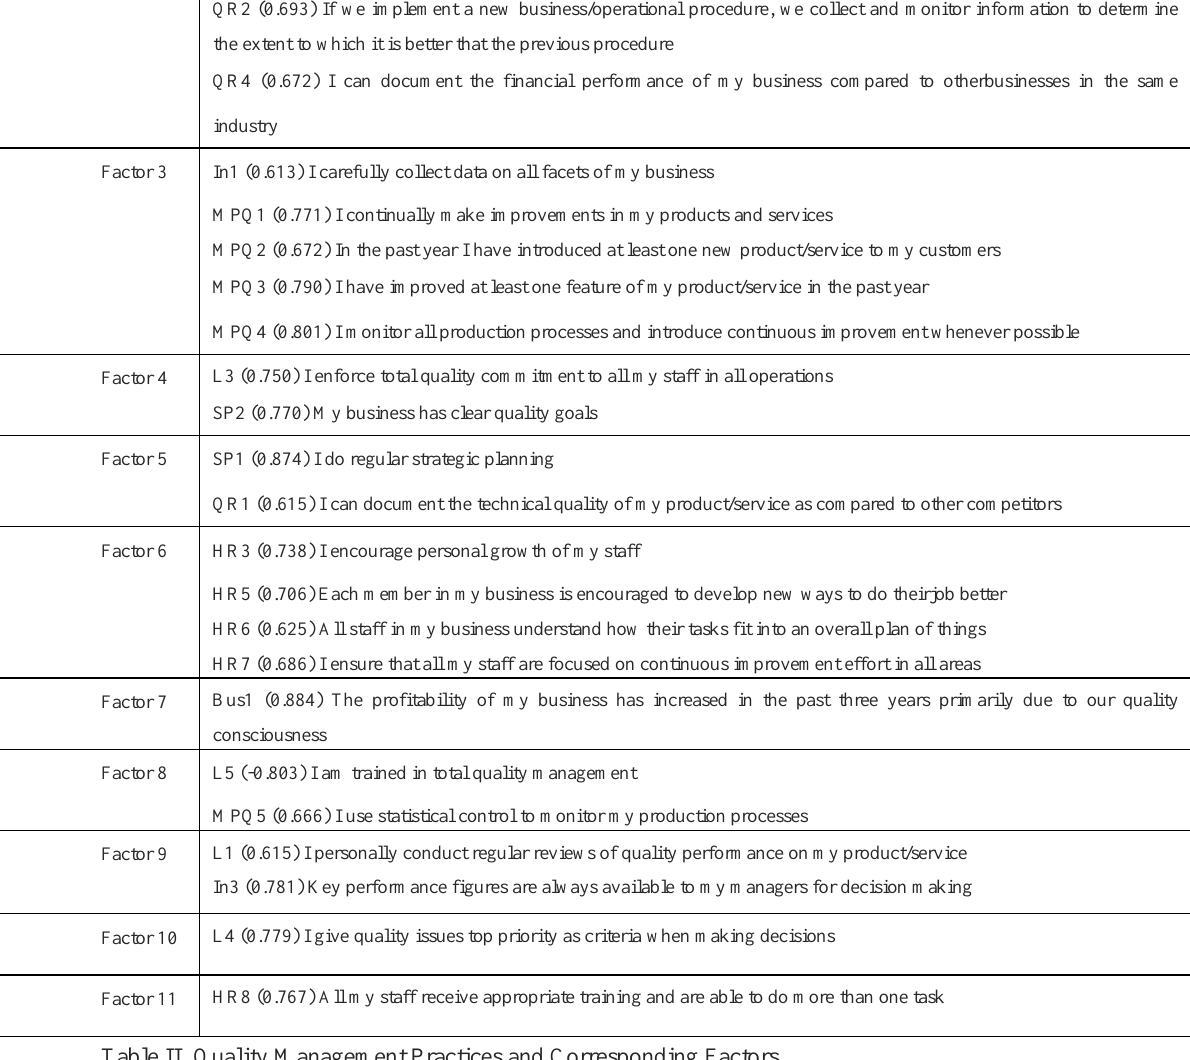
Table II. Quality Management Practices and Corresponding Factors